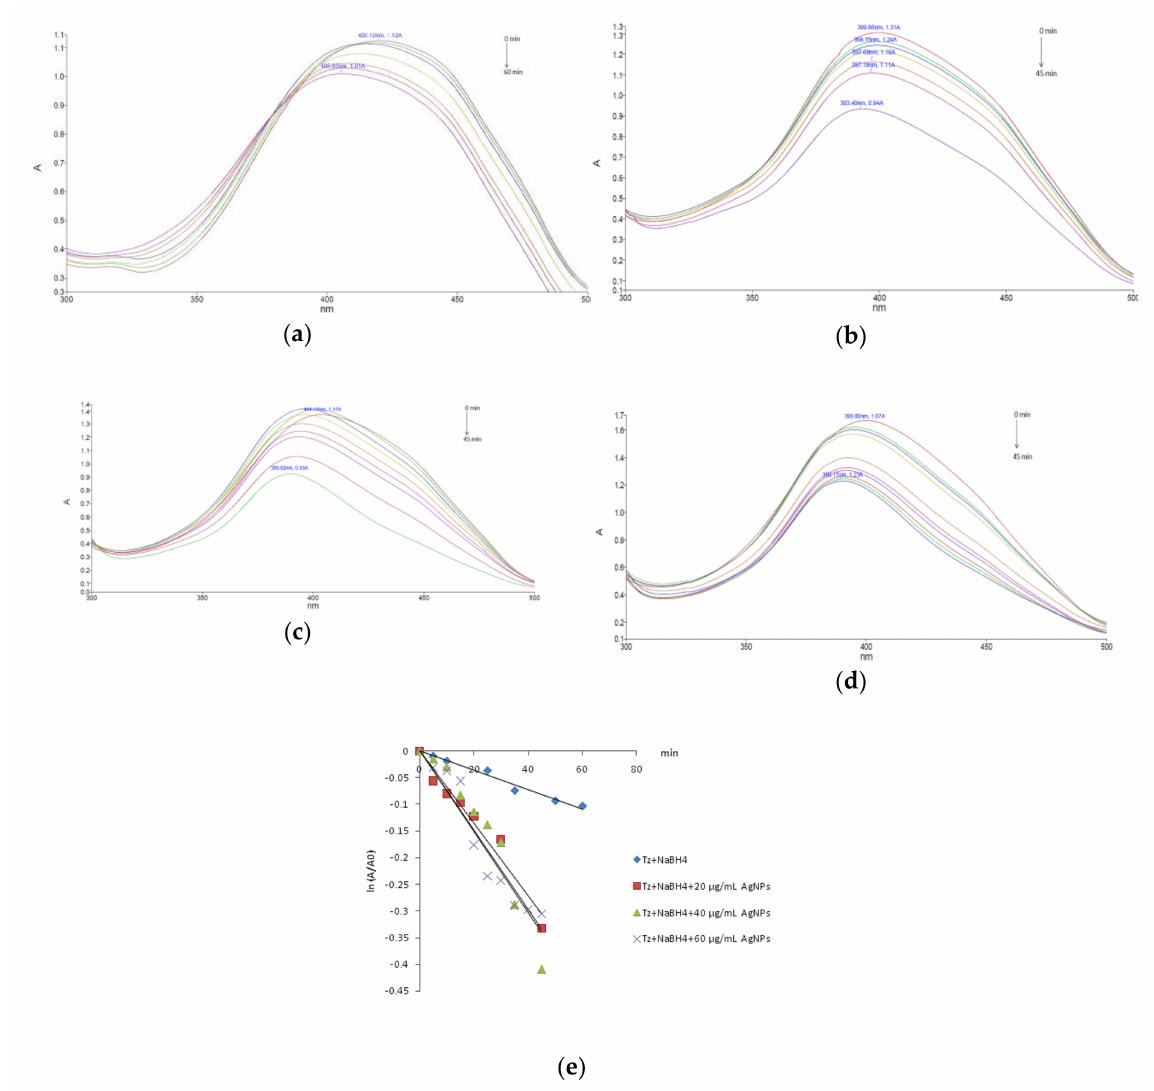
Figure 8. NaBH 4 mediated tartrazine degradation: ( a ) without a catalyst; ( b ) in the presence of 20 µ g / mL AgNPs; ( c ) in the presence of 40 µ g / mL AgNPs; ( d ) in the presence of 60 µ g / mL AgNPs and ( e ) kinetics